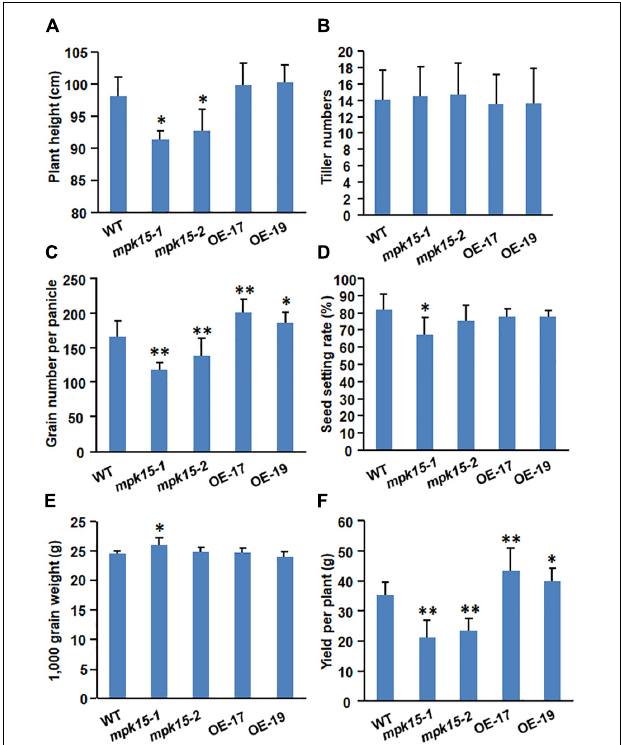
FIGURE 7 | Agronomic phenotypes of the WT, mpk15 mutant, and OsMPK15-OE lines. (A,B) Comparison of plant height and tiller numbers among the WT, mpk15 mutant, and OsMPK15-OE plants ( n = 10). (C–F) Comparison of grain number per panicle, seed setting rate, 1,000-grain weight, and yield per plant among the WT, mpk15 mutant, and OsMPK15-OE lines ( n = 10). Data presented are the mean ± SD from 2 years of independent experiments with a similar result. ∗ P ≤ 0.05; ∗∗ P ≤ 0.01 (Student’s t -test).